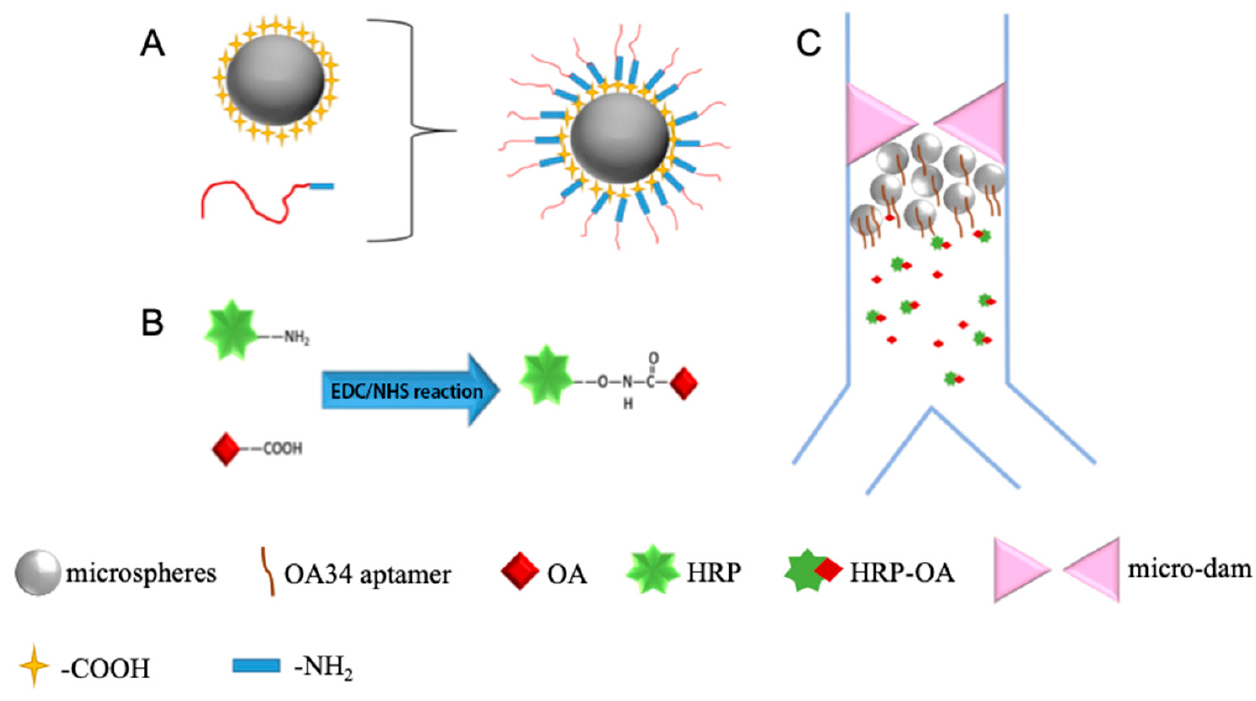
Figure 1. ( A ) Diagram of aptamer-functionalized microsphere to isolate OA; ( B ) diagram of coupling of OA to HRP; ( C ) diagram of the direct competitive chemiluminescent scheme.